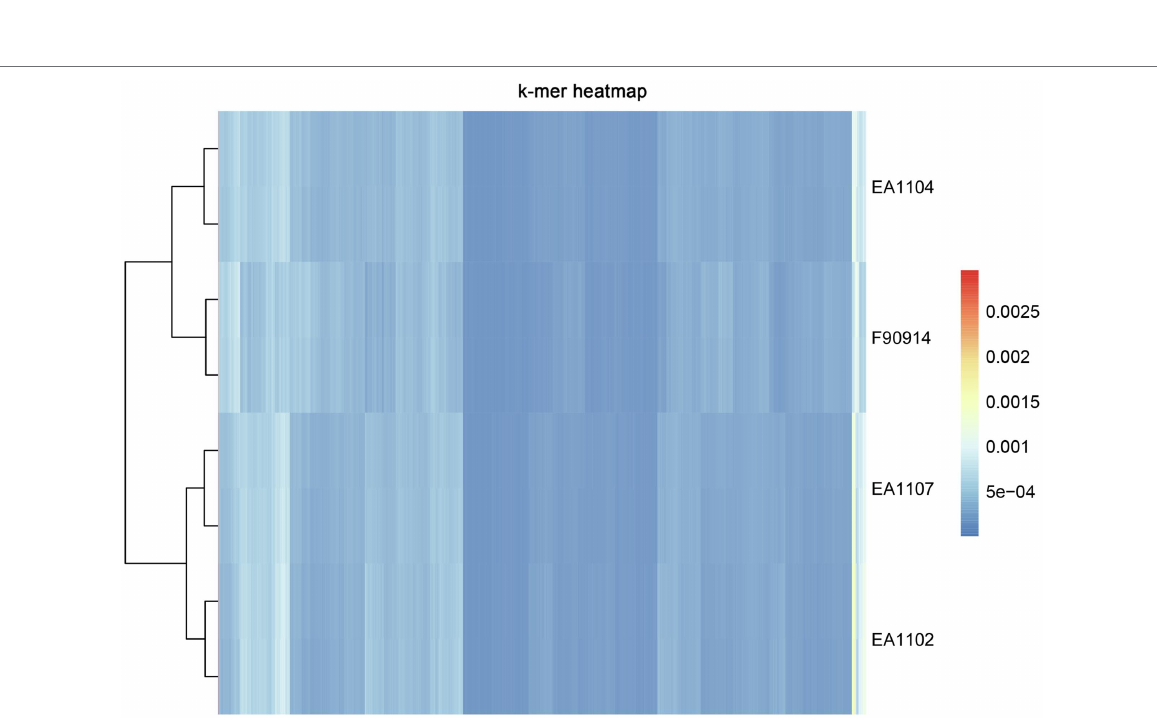
FIGURE 1 | Library complexity curves described as the expected distinct reads as the function of the total reads. These curves were estimated by all of the mapped reads in BAM files using the lc_extrap module from preseq (Daley and Smith, 2013).